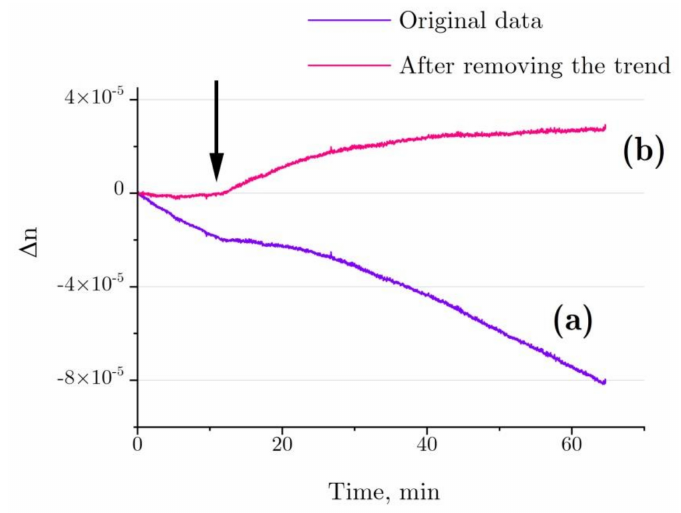
Figure 8. ( a ) Typical refractive index change for the denaturation of 4 mg/mL HEWL in 6 M GdnHCl, 30 mM DTT, and 50 mM Tris in the test cell, as compared with 6M GdnHCl, 30 mM DTT, and 50 mM Tris in the control cell. ( b ) After deduction of the trend associated with water evaporation. The arrow indicates the point of time at which lysozyme was added into the test cell (with Tris added into the control cell